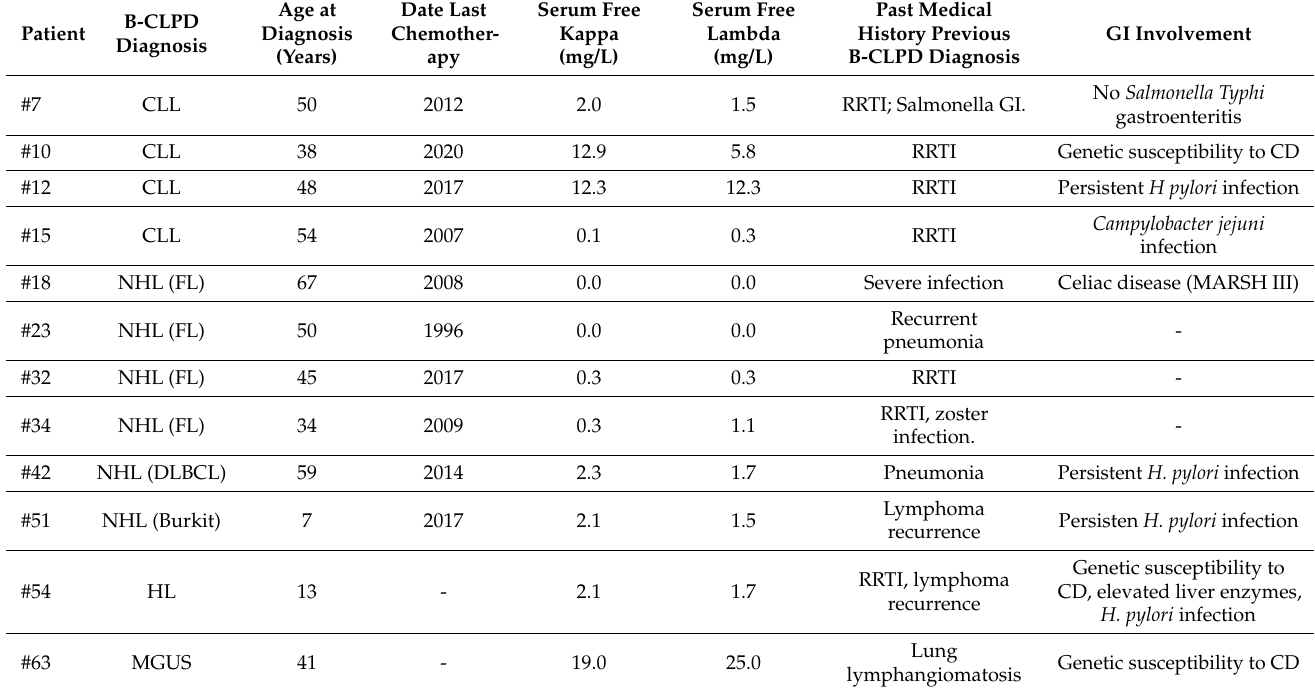
Table 5. Patients with suspected primary